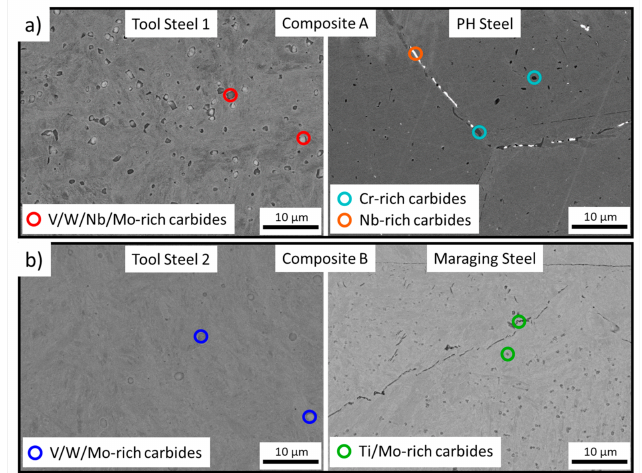
Figure 6. Backscattered electron images close to the interface with marked positions of the EDX spot measurements for ( a ) composite A and ( b ) composite B. Carbides rich in V, W and Mo were found for both cold work tool steels. In the PH steel both Cr and Nb rich carbides were detected. For the maraging steel only Ti and Mo rich carbides were observed.